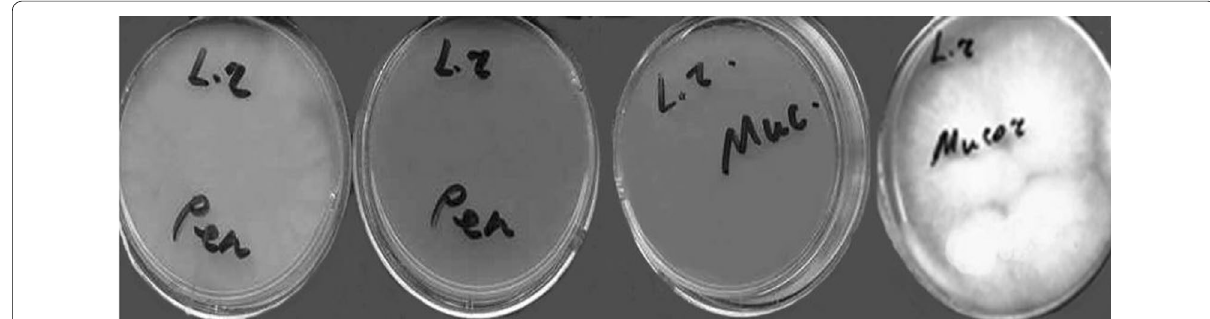
Fig. 3 The antifungal activity of L. rhamnosus MDC 9661 disintegrated biomass. The supernatant of disintegrated biomass was added in Petri dishes where the growth of mycelium can be seen (the side) and the sediment of disintegrated biomass was added in Petri dishes where the growth of mycelium cannot be seen (in the middle of Fig.). For details see “Materials and methods”